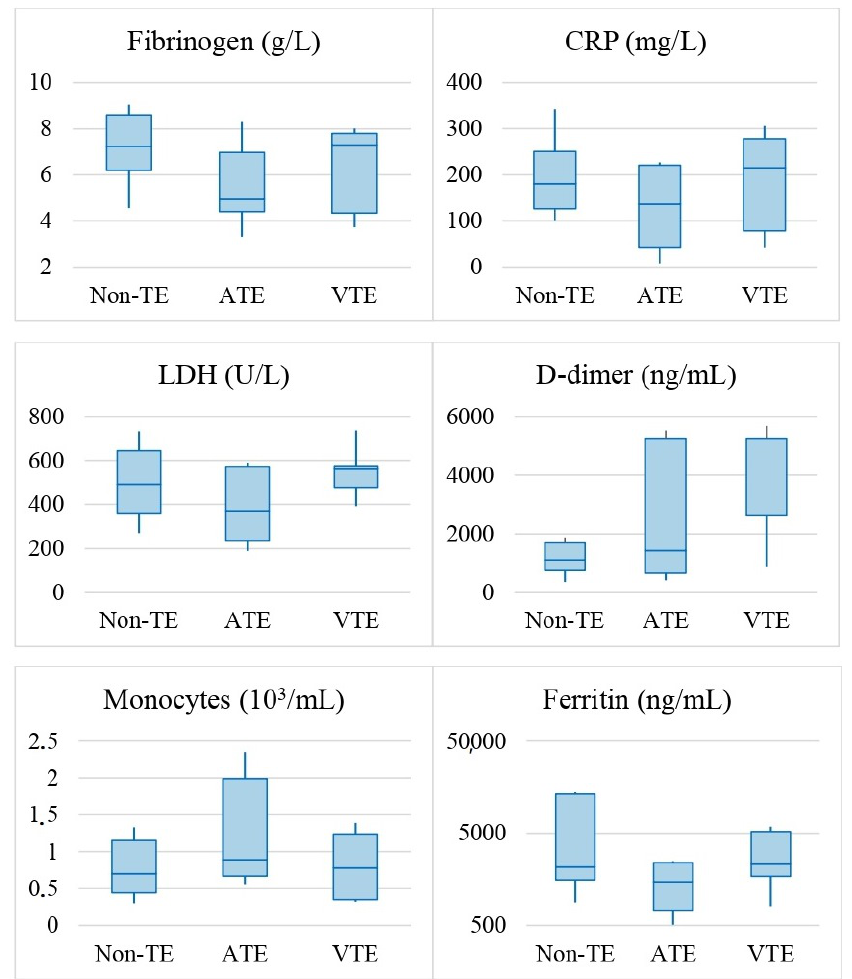
Figure 1. Boxplots of statistically significant laboratory parameters upon hospital admission of patients with non-TE, ATE or VTE. Comparisons were conducted using the Kruskal–Wallis H test. A p value of <0.05 was considered statistically